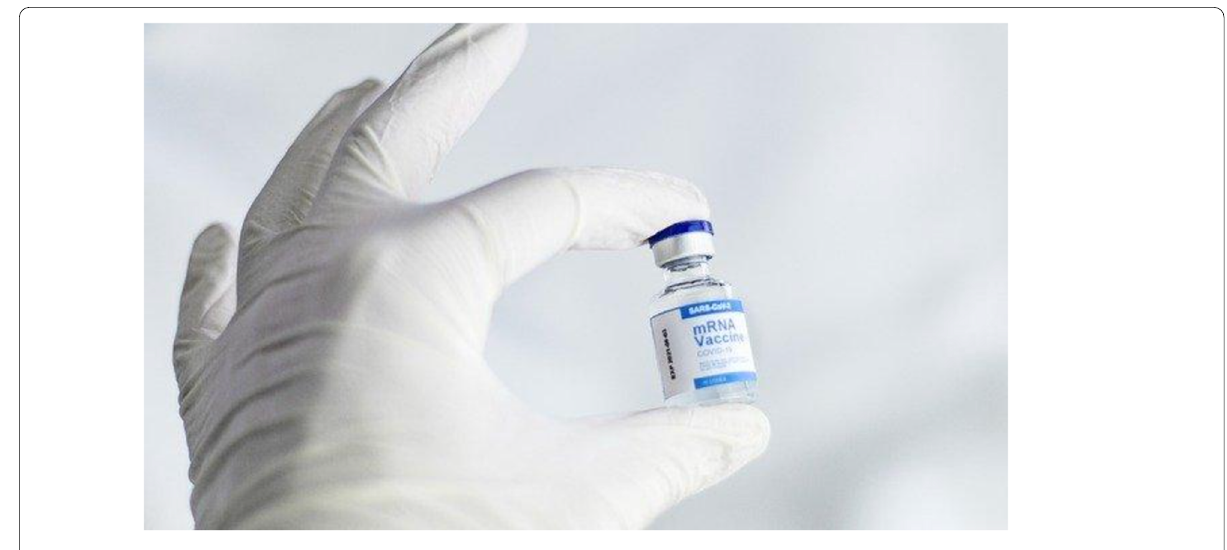
Fig. 6 Example of pro-vaccine novel